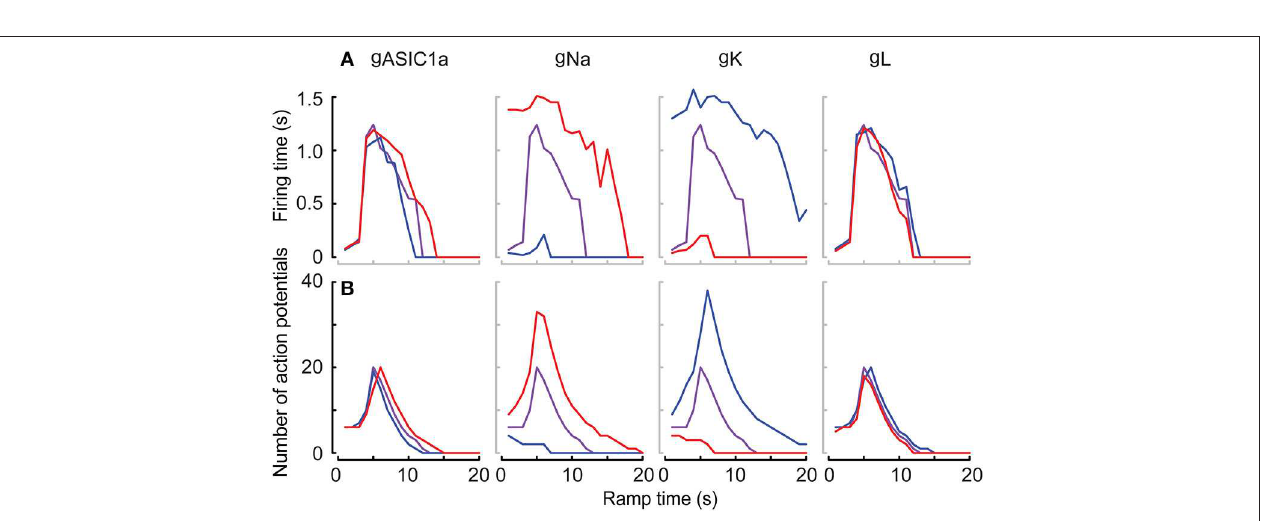
FIGURE 10 | Responses of the neuronal models to the variability of the conductance parameters. Responses in terms of firing time and number of APs of the Hodgkin-Huxley neuronal model integrating the ASIC1a model with pH 7.4–6.0 ramps. The differently colored lines highlight the effect of varying the maximal conductance of ASIC1a (g ASIC ), sodium (g Na ), and potassium (g K ) channels, as well as of the leak current (g L ) by ± 10% of the optimized corresponding parameters. The firing time (A) and the number of APs (B) are shown in purple for optimized parameters, and as blue and red lines for optimized corresponding parameters − 10% (blue) and + 10% (red). Note that the speed of pH ramps is presented here as total ramp time, and not ramp FT, as in other